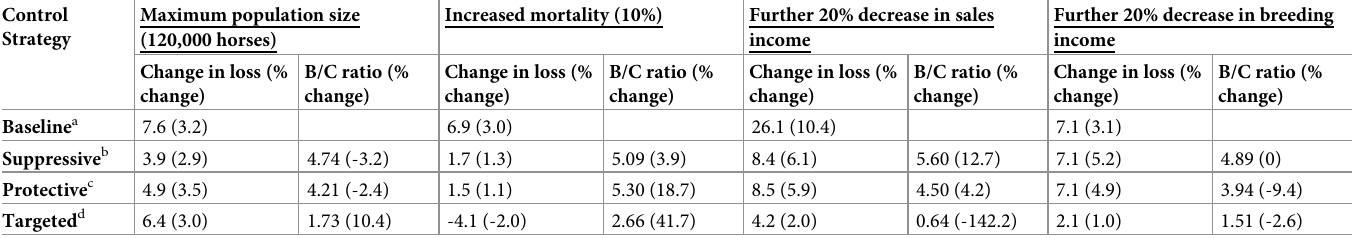
Table 6. The overall loss, benefit cost ratios (B/C) and percentage change compared to the original economic models for four sensitivity models; Increasing the horse population size, increasing mortality, decreasing sales income and decreasing breeding income for scenarios. Sensitivity analysis was conducted only for the first three months of the breeding season (August to October). The duration of the outbreak, number of infected and vaccinated properties determined through simulation